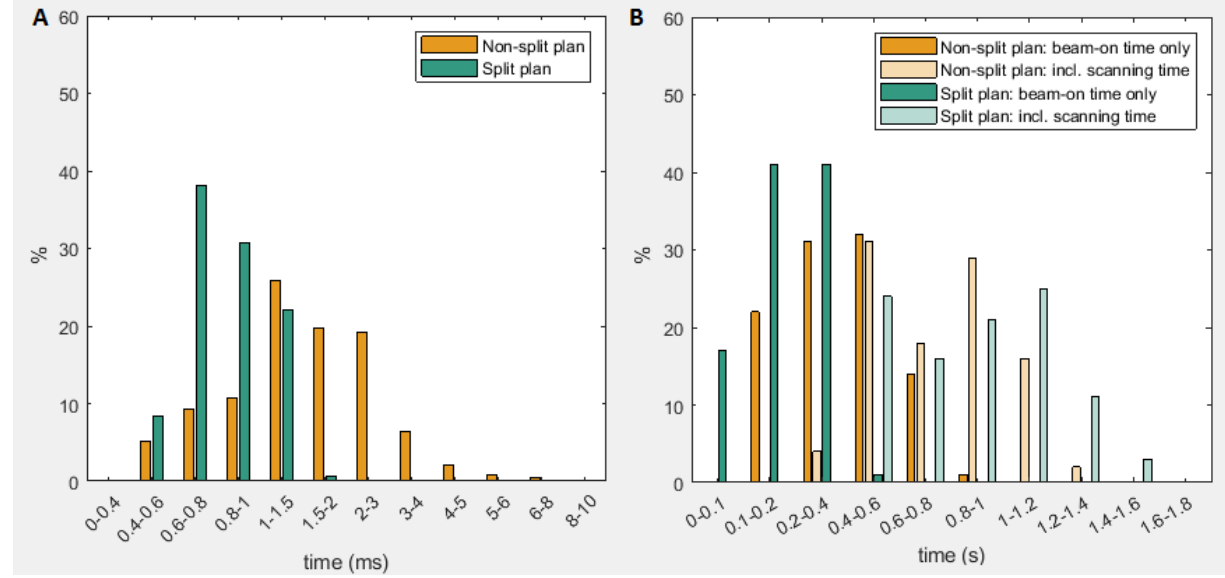
Figure 4. ( A ) spot time distribution for all spots of all 100 beams; ( B ) beam time distribution for all 100 beams.